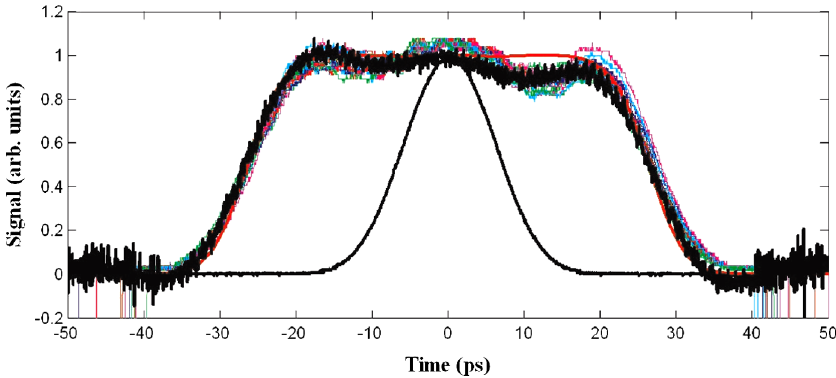
FIG. 3. (Color) Cross correlation recorded every (cid:1) 10 min over a 4 h period, demonstrating the short and long term stability, (thick black line) a deconvoluted pulse, (red line) theoretical pulse; and (thin black line) autocorrelation of the incident laser